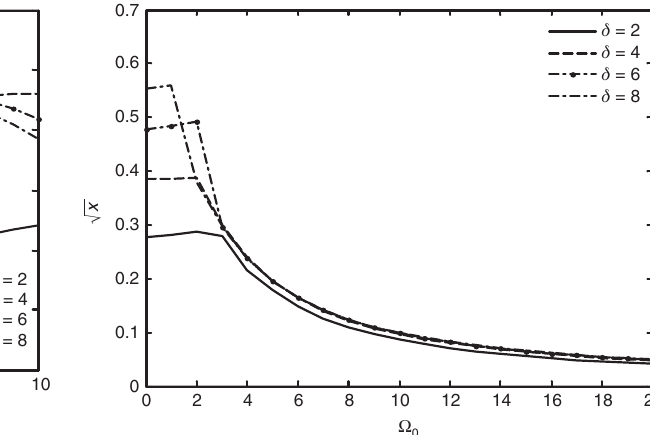
Figure 9: Variations of non-dimensional phase speed ( ) x against impedance parameter δ